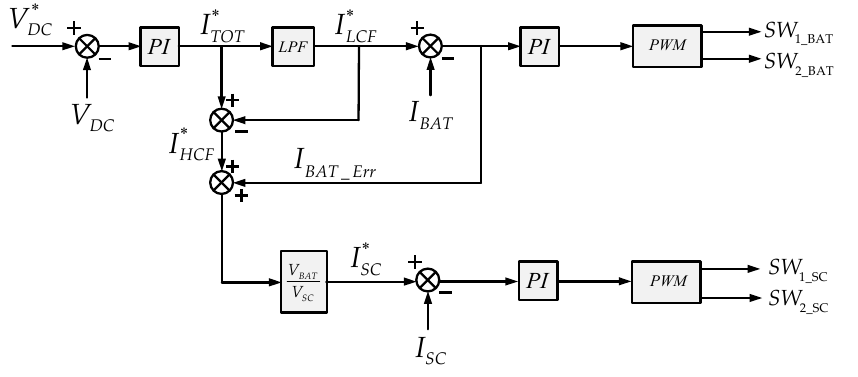
Figure 3. HESS Controller.